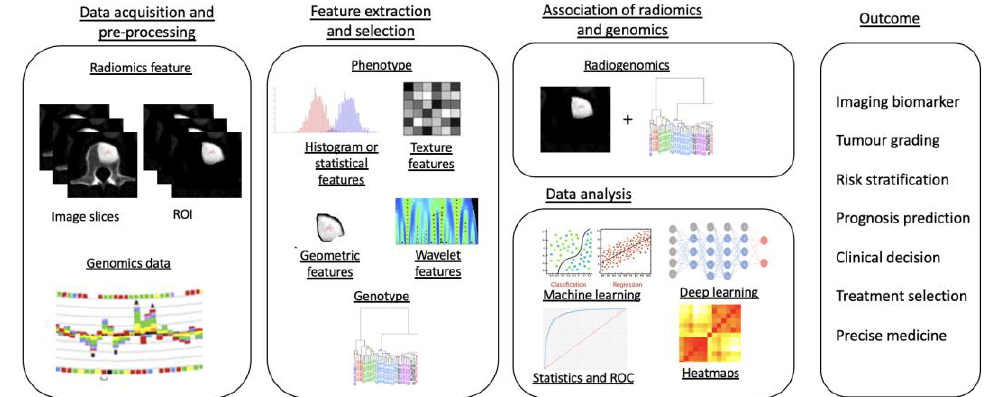
Figure 5. Diagram showing a five-stage radiogenomics pipeline including data acquisition (radiological imaging) and pre-processing, feature extraction and selection, subsequent association of radiomics techniques and genomics, analysis of data and model development and, finally, radiogenomics outcomes.